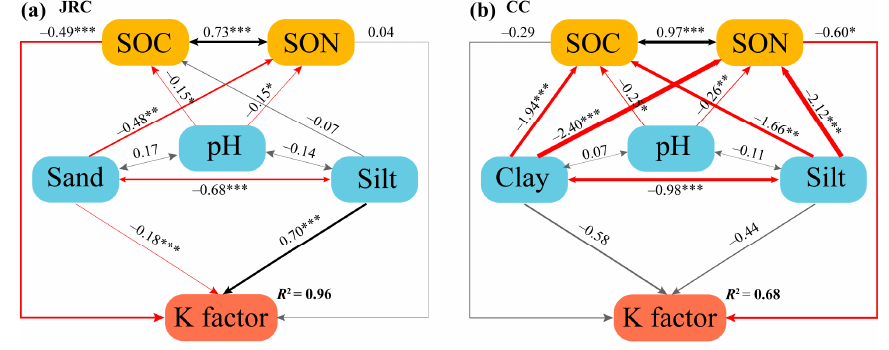
Figure 4. Structural equation model (SEM) evaluating the direct and indirect effects on the K factor in the JRC ( a ) and in the CC ( b ). In the SEM of the JRC, soil samples come from the profiles of YS and RS ( n = 187, df = 3); in the SEM of the CC, soil samples come from all 18 soil profiles ( n = 83, df = 1). Black and red lines indicate significantly positive and negative relationships, respectively; gray lines indicate the relationships are not significant at p = 0.05 level. The thickness of lines represents the magnitude of the path coefficient; numbers adjacent to lines are standardized path coefficients; these are analogous to relative regression weights and to indicate the effect size of the relationships. Single-headed arrows represent hypothetical causal relationships tested by the model. Double-headed arrows represent an unresolved covariance. Goodness-of-fit tests for the model are shown below the model. * p < 0.05, ** p < 0.01, *** p < 0.001.